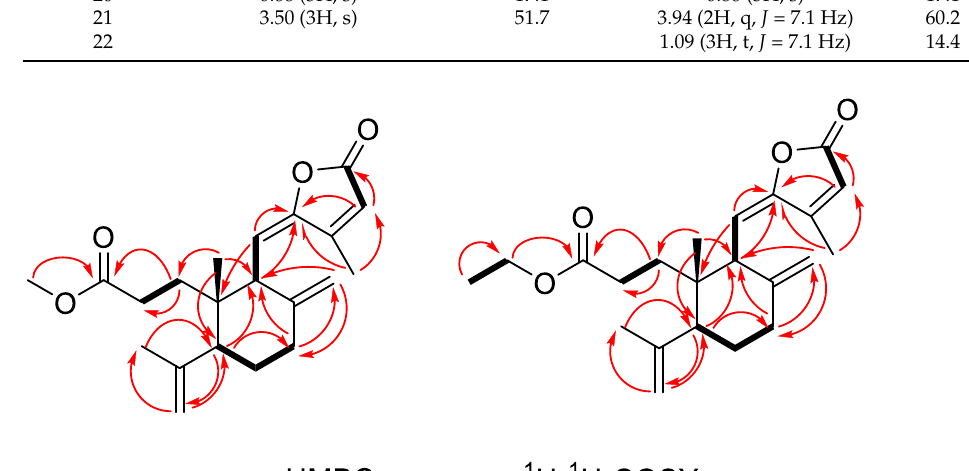
Figure 2. Selected HMBC and 1 H- 1 H COSY correlations of 1 and 2 .